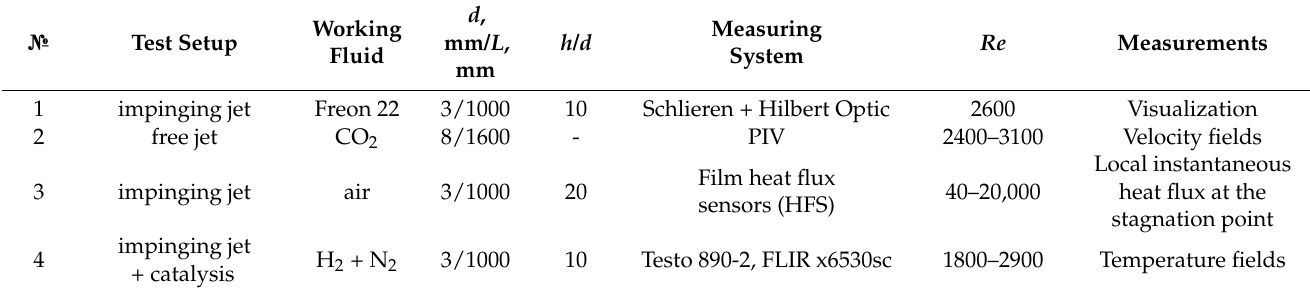
Table 1. Experimental